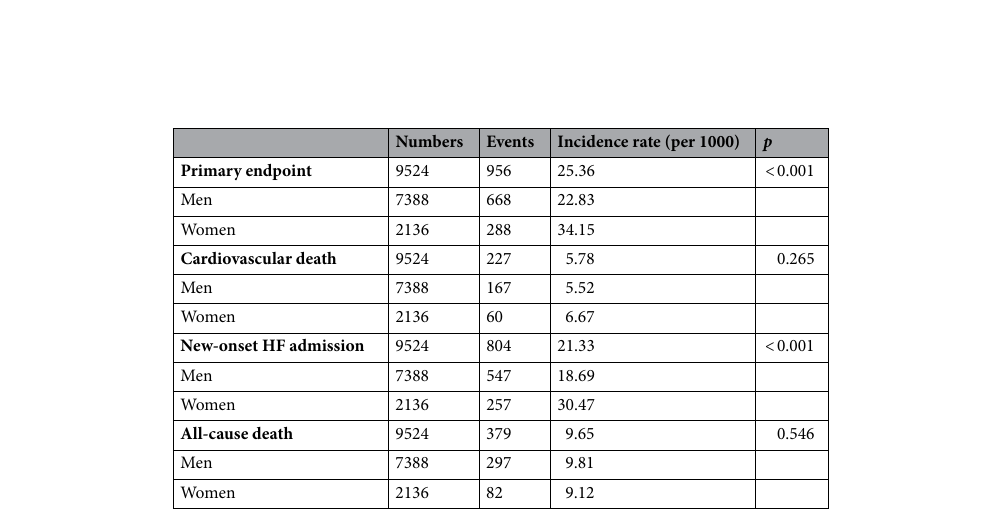
Table 2. Clinical outcome in the original cohort of patients with HCM. HCM hypertrophic cardiomyopathy, HF heart